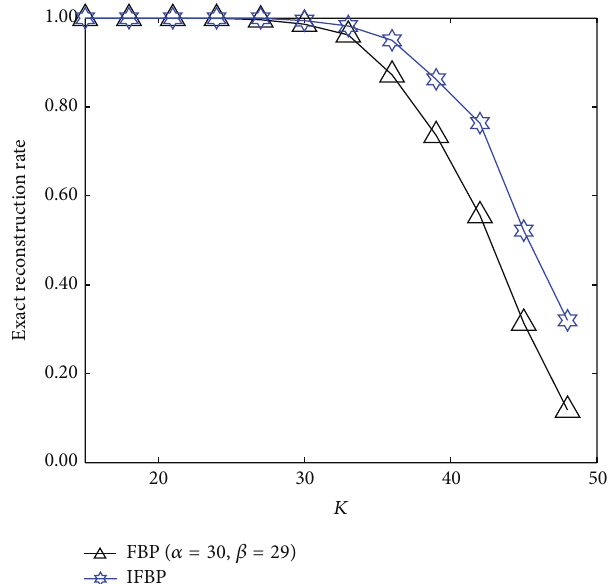
Figure 7: Exact recovery rates for the uniform sparse vectors ( 𝛼 = 30 , 𝛽 = 29 ).